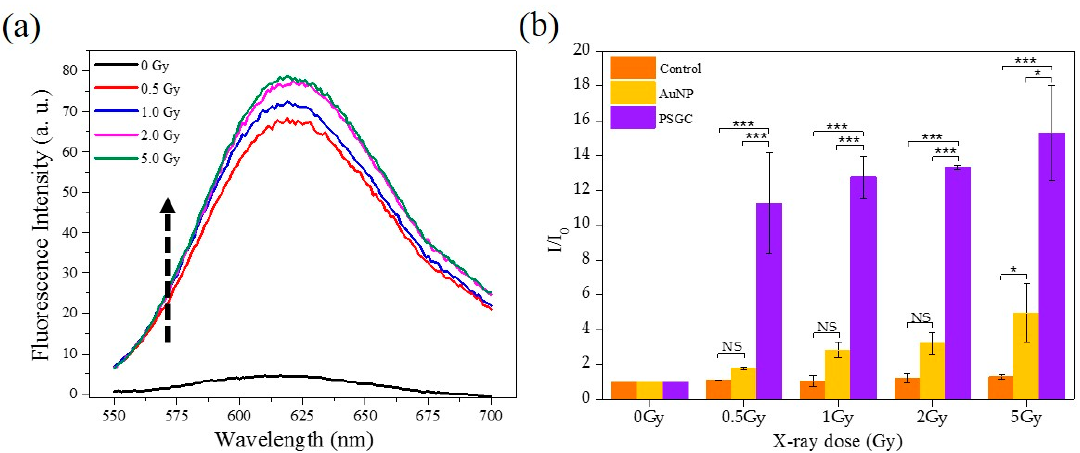
Figure 3. ( a ) Fluorescence emission spectra of dihydroethidium (DHE) in PSGCs aqueous solution with different irradiation doses. ( b ) DHE fluorescence intensity enhancement for water, gold nanoparticles (AuNPs), and PSGCs with a variety X-ray irradiation doses. Statistical significance is denoted as follows: * represents a p value ≤ 0.05 and *** represents a p value ≤ 0.001. NS indicates that a value is not statistically significant.